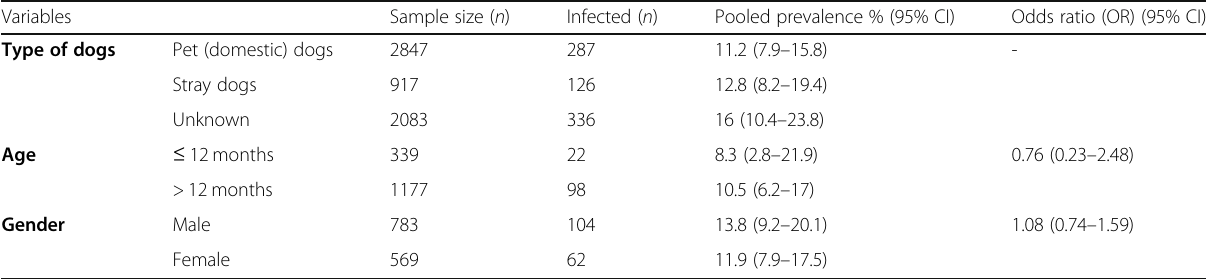
Table 5 Subgroup analysis of animal type, age and gender in dogs Variables Sample size ( n ) Infected ( n